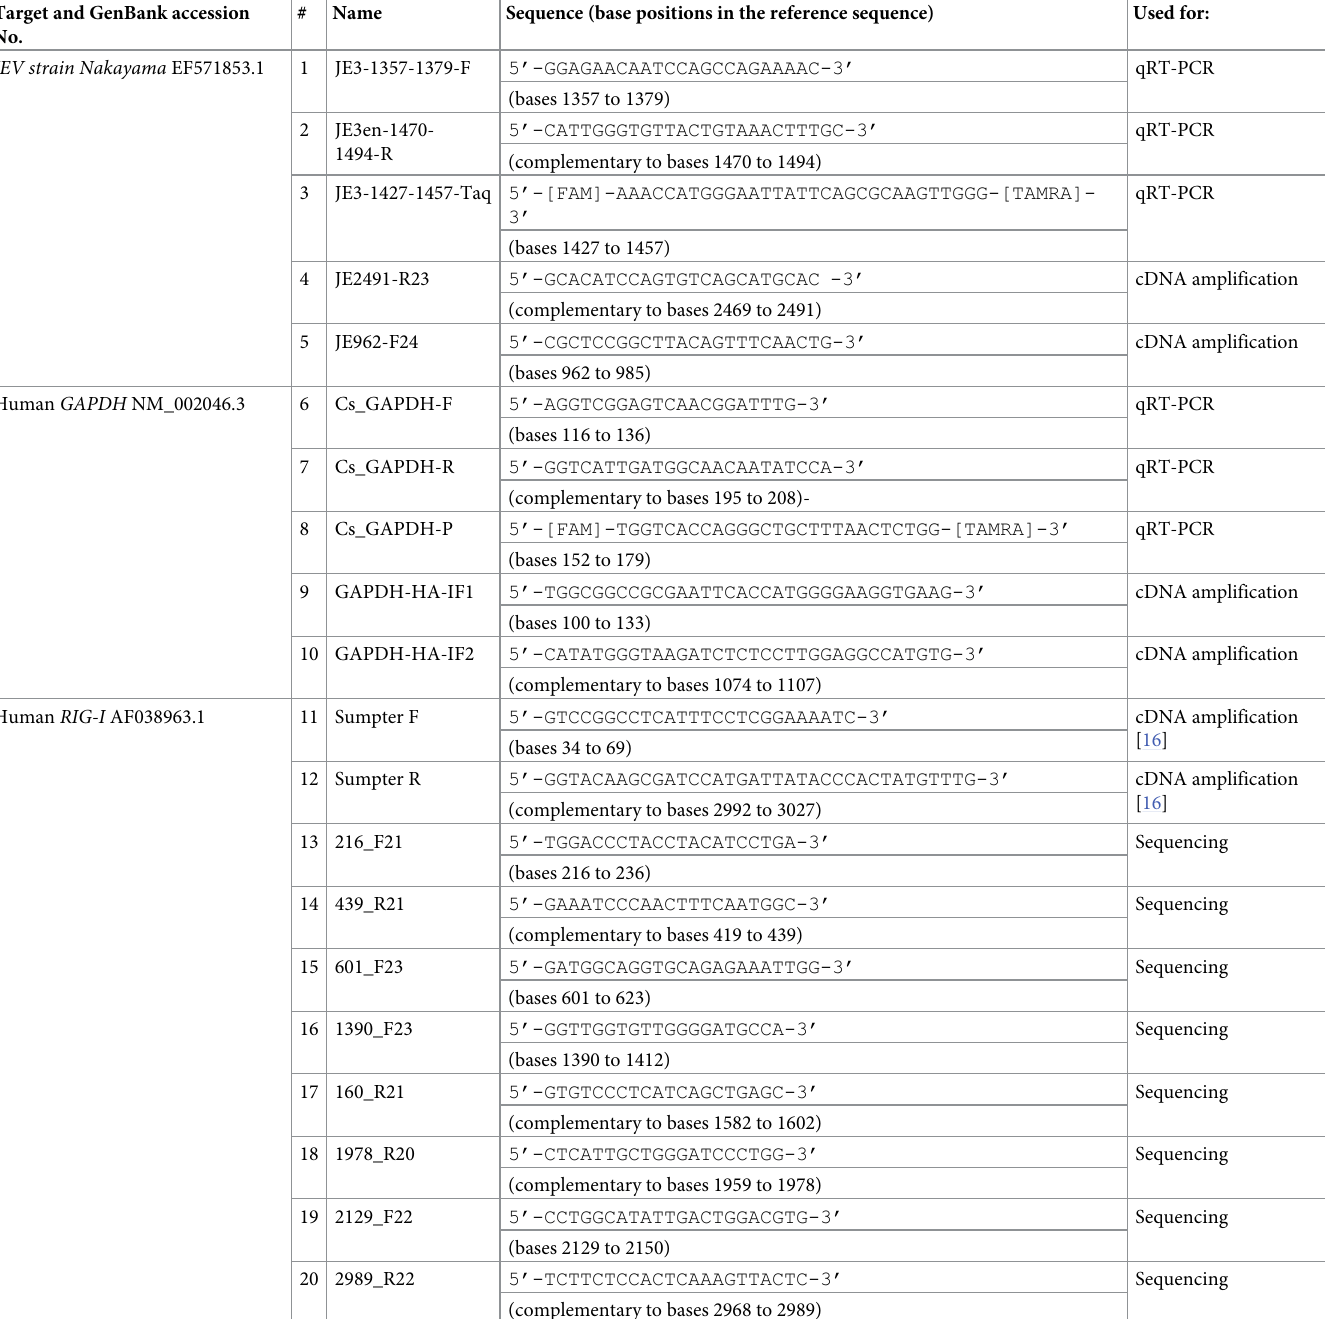
Table 1. Primers and probes used in this study. Target and GenBank accession Name Sequence (base positions in the reference sequence) Used No.